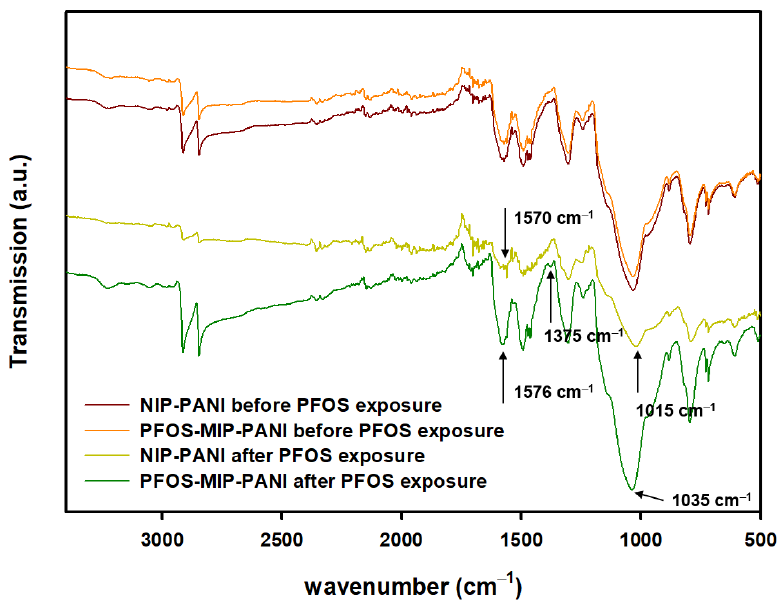
Figure 2. ATR-FTIR spectra of the surface of PFOS-MIP-PANI and NIP-PANI. NIP-PANI denotes the polyaniline synthesized in the absence of PFOS templates while the template removal process including sonication was still performed. The y axis based on the transmission mode has been adjusted in order to compare wavelengths of the characteristic peaks.